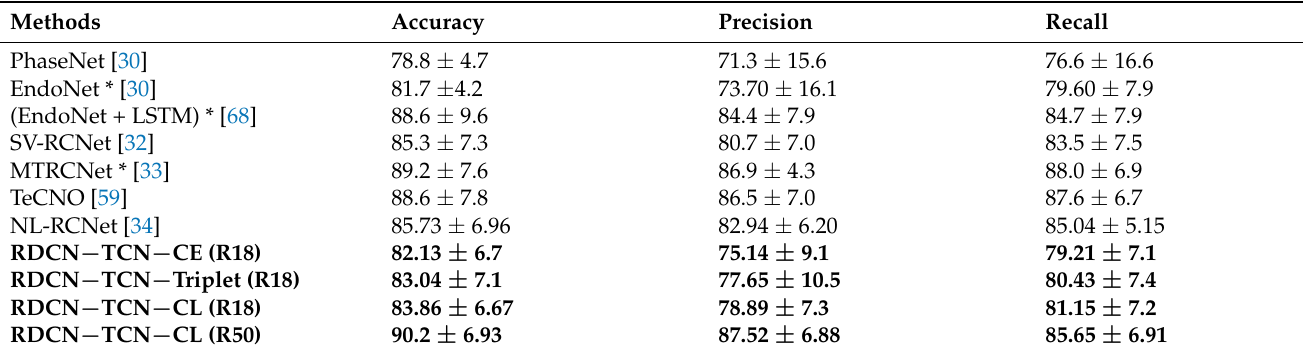
Table 7. Surgical workflow recognition performance on